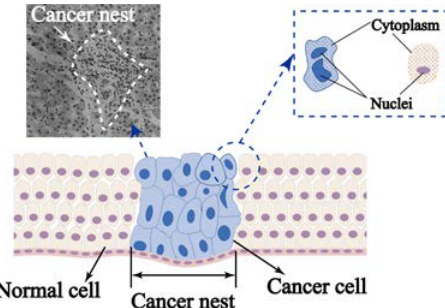
Fig. 3. Diagrammatic sketch of tissue with normal and cancer cells and cancer nest captured using HSI